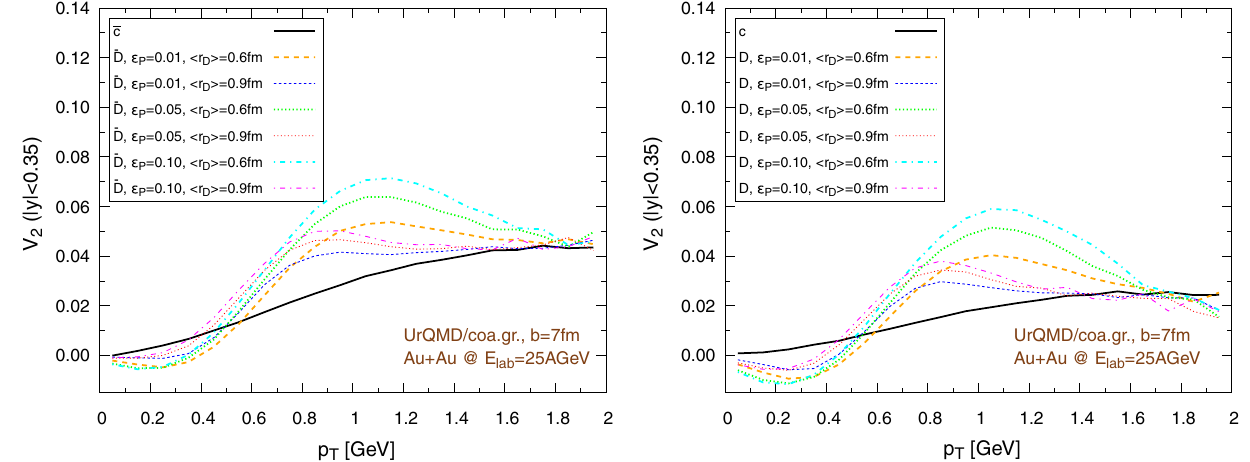
Fig. 26 Au+Au collisions at E lab = 25AGeV, b = 7fm in the UrQMD/coarse-graining approach. Elliptic flow of charm quarks and D-mesons ( | y | < 0 . 35). We explore the effect of different choices of